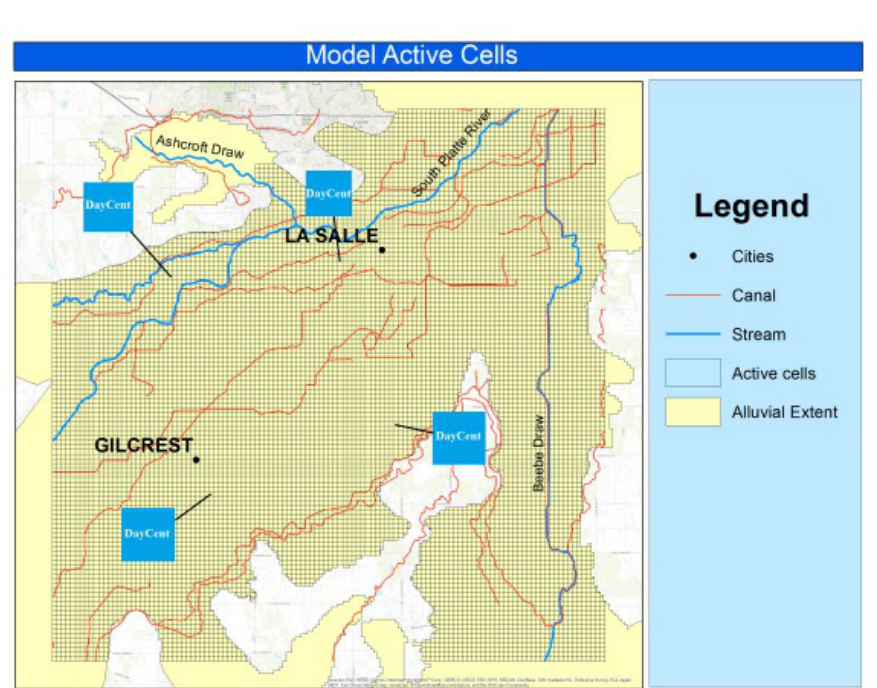
Figure 2. ( A ) is the digital elevation model (DEM) and gird discretization of the study area in the MODFLOW model. The topography includes a broad fluvial valley along the South Platte River. The land surface has an elevation of 1510 m in the south. ( B ) shows the MODFLOW grid, canals, streams, and active cells of the study